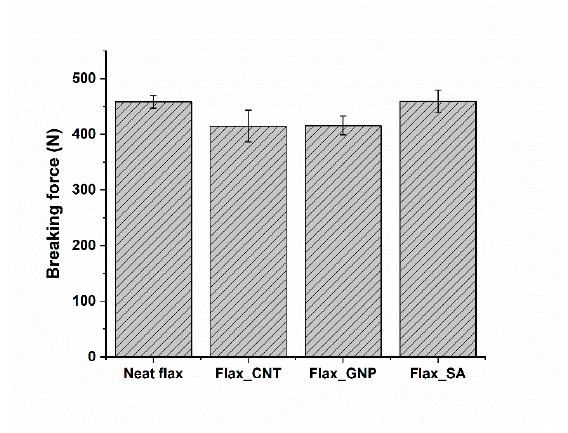
Figure 4. Breaking forces of untreated and surface-modified flax fabrics.